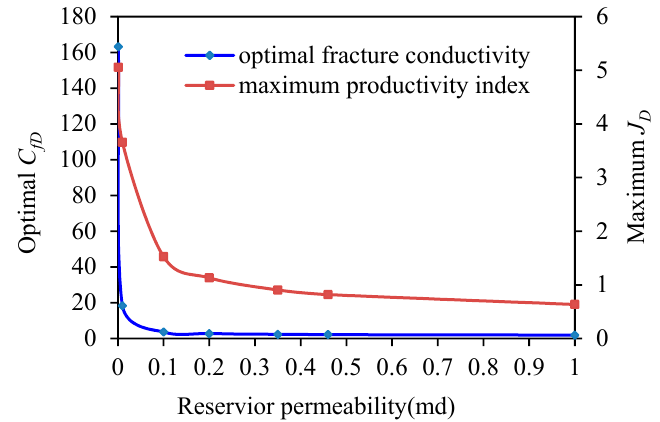
Figure 13. Optimal (cid:1829) (cid:3033)(cid:3005) and maximum (cid:1836) (cid:3005) values vs. reservoir permeability. Figure 13. Optimal C fD and maximum J D values vs. reservoir permeability.